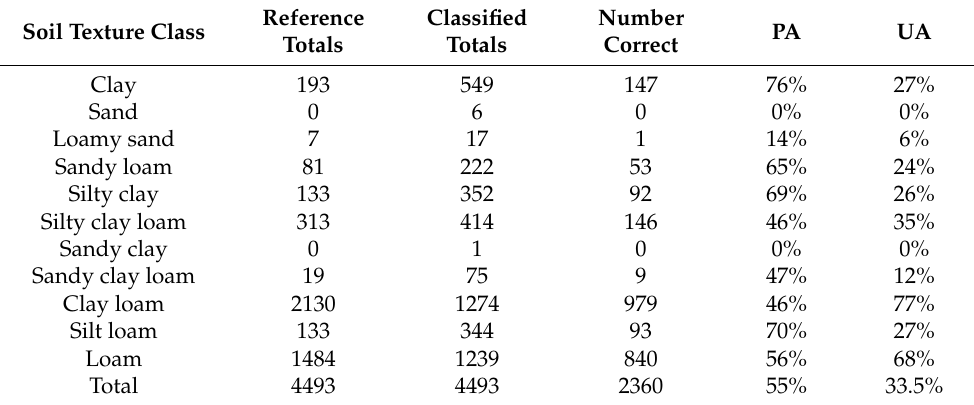
Table 9. Accuracy assessment results of the studied area’s soil texture class prediction map.